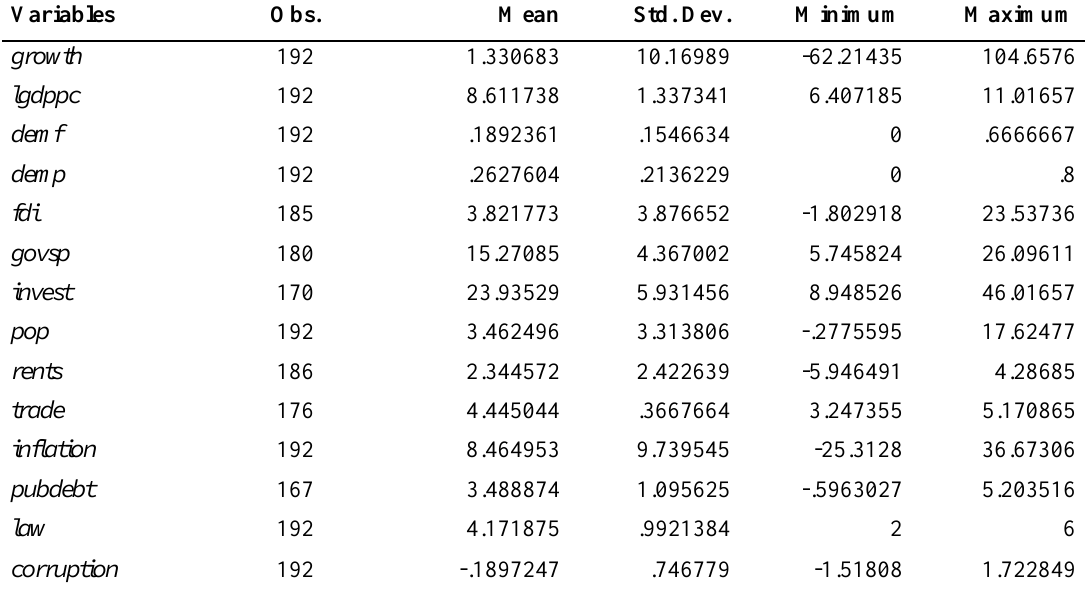
Table A.2: Summary statistics